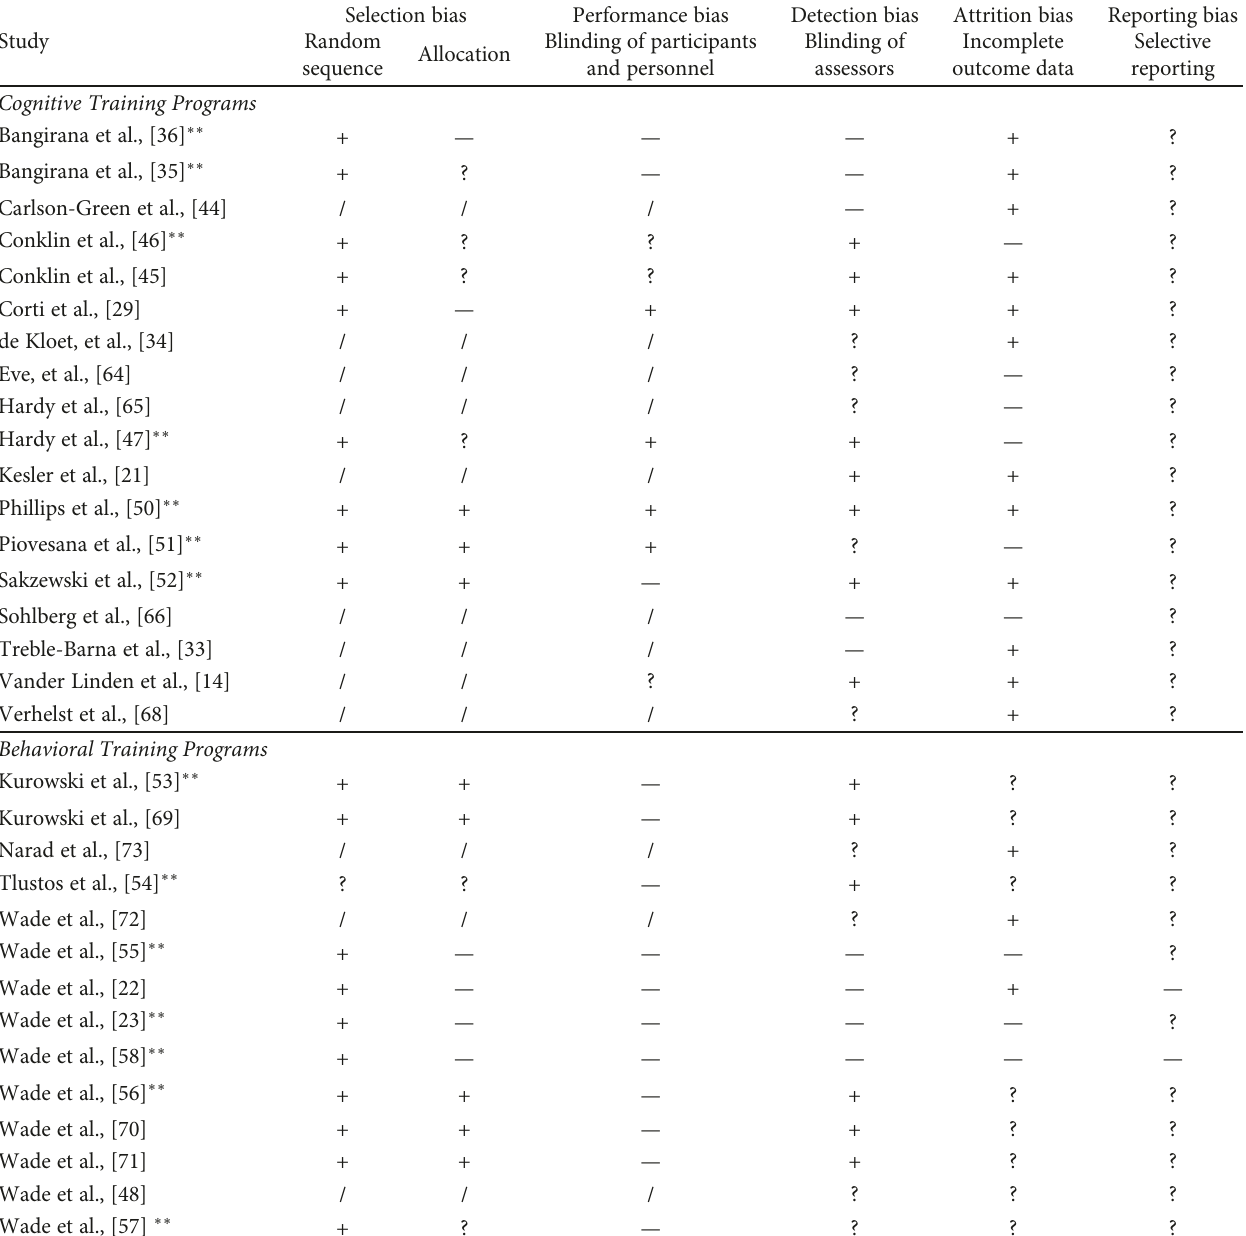
Table 3: Risk of bias